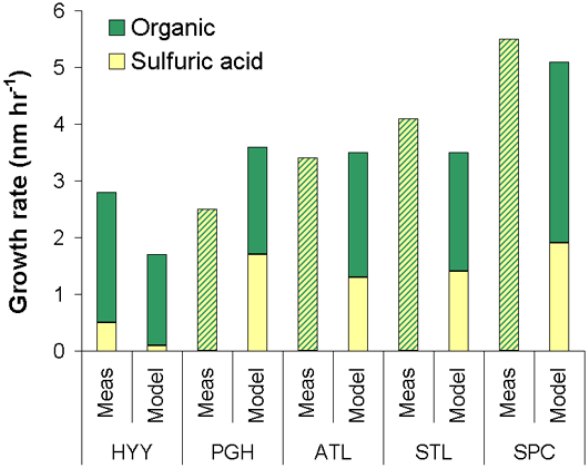
Fig. 11. Annually averaged growth rate as a function of condens- ing vapor chemical species, either low volatility organics or sulfu- ric acid, for observations and model (ternary nucleation with 10 − 5 tuning factor simulation) results at each of the five locations. Green shading represents organic condensation and yellow represents sul- furic acid. Sulfuric acid measurements (and therefore speciation analyses) were only available at Hyyti¨al¨a for the simulated time periods. For these sites without measurements, total growth rate is plotted without knowledge of breakdown between condensing va- por (yellow with green shading). Units are in nmh − 1